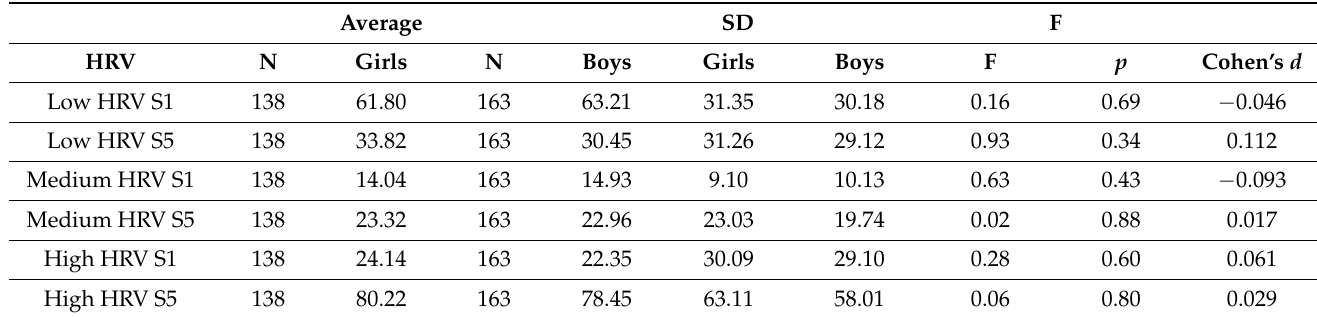
Table 4. Variance analysis in HRV results in S1* and S5* based on gender.